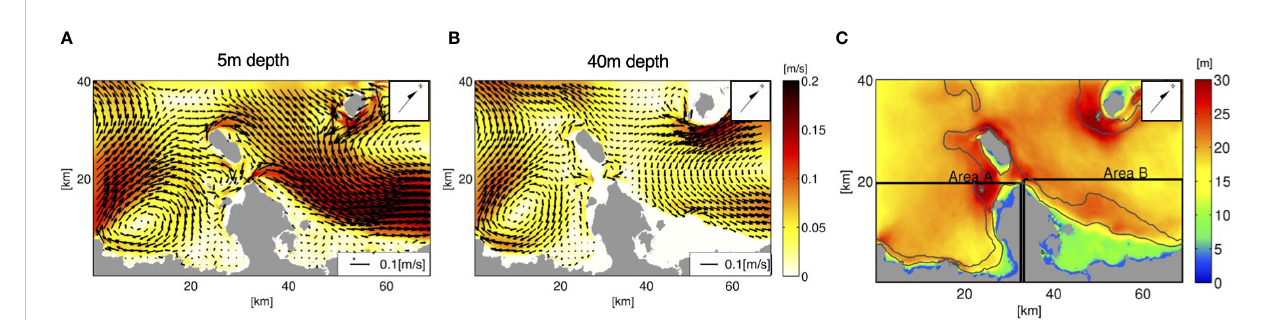
FIGURE 6 Time-averaged fl ow fi elds based on the ROMS-L4 model output for the 1-month period of June, 2013. The horizontal velocity vectors (A) at a 5 m depth (near-surface) and (B) at a 40 m depth (mesophotic zone), overlaid on their absolute values (m/s) indicated by color, are depicted. (C) The surface mixed-layer depth H bls (m) is indicated by color, with the two black rectangles showing areas A and B used for the analyses in sections 3.2 and 4.2. The black solid contours indicate the isobaths of 30 and 100 m depths. Arrows point to the true